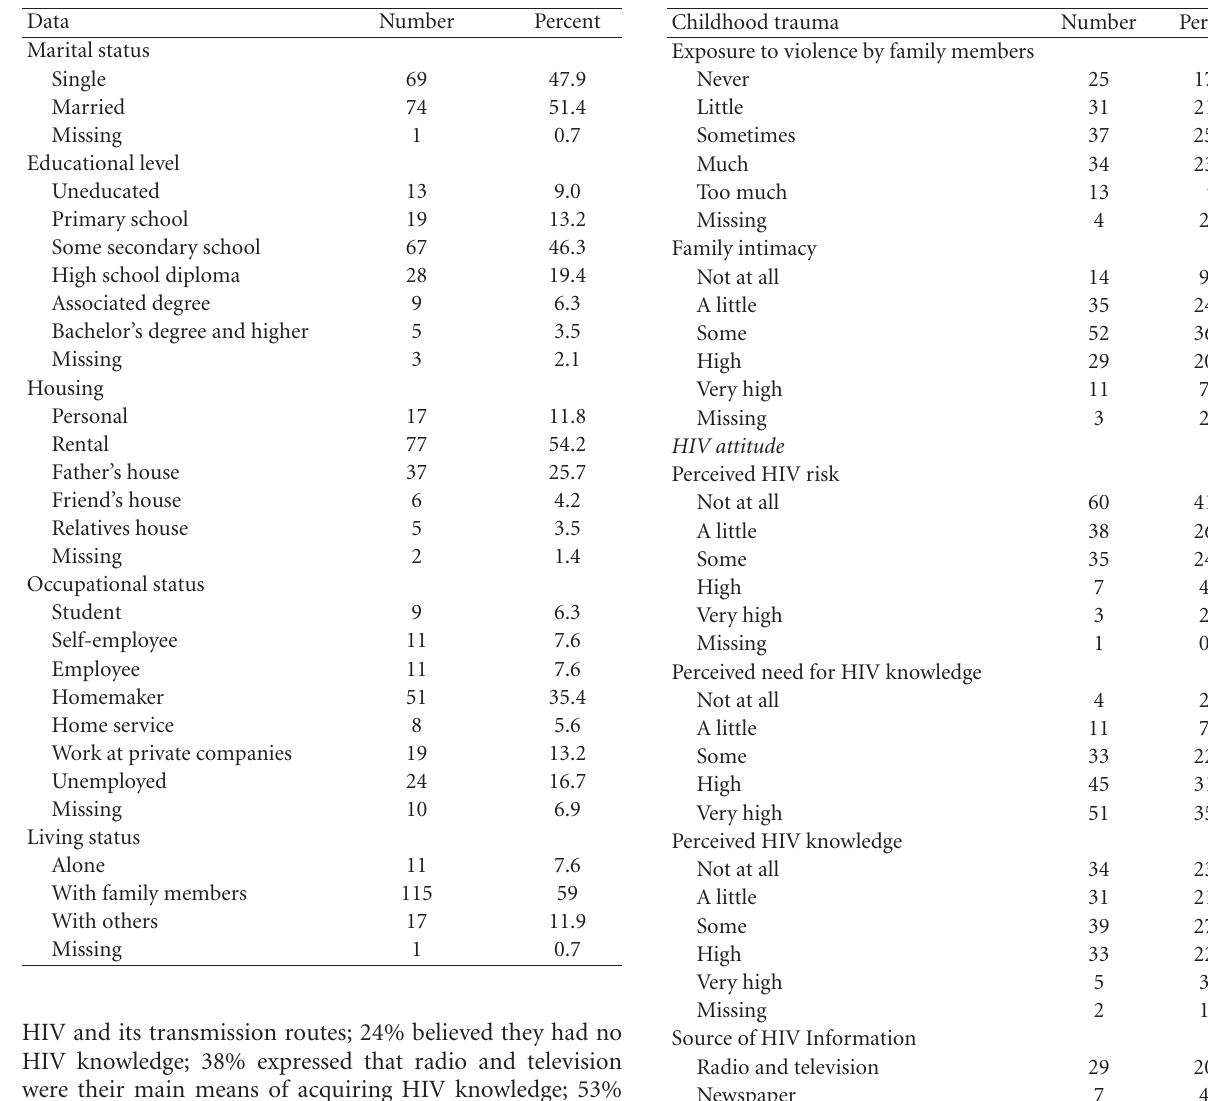
Table 1: Sociodemographic data among Iranian female sex workers who have sex with injecting drug users ( n = 144).